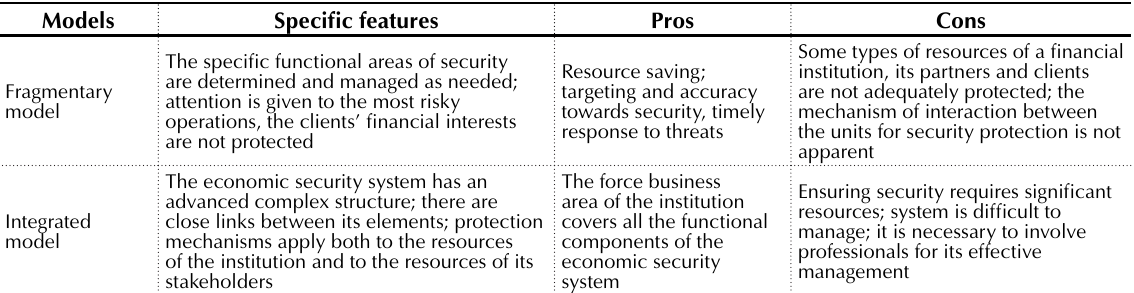
Table 2. Characteristics of models of economic security management of financial intermediaries